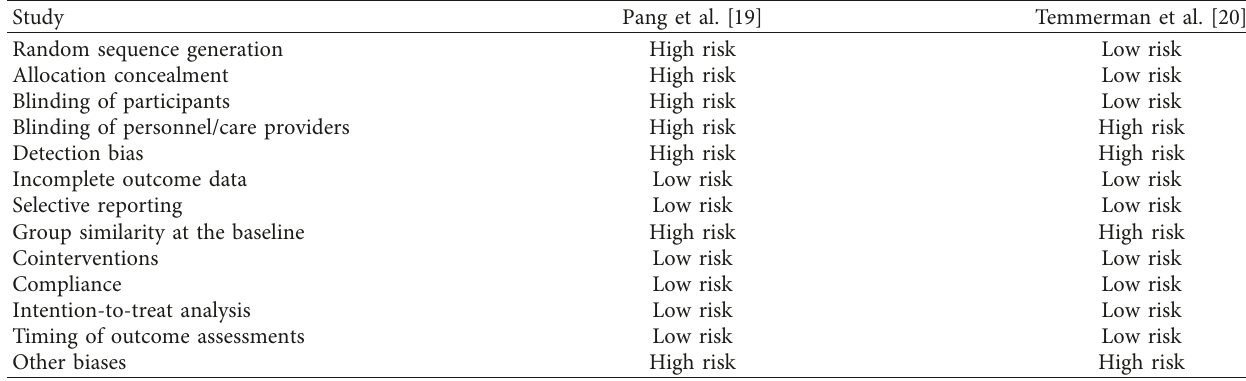
T ABLE 2: The risk of bias for both studies.